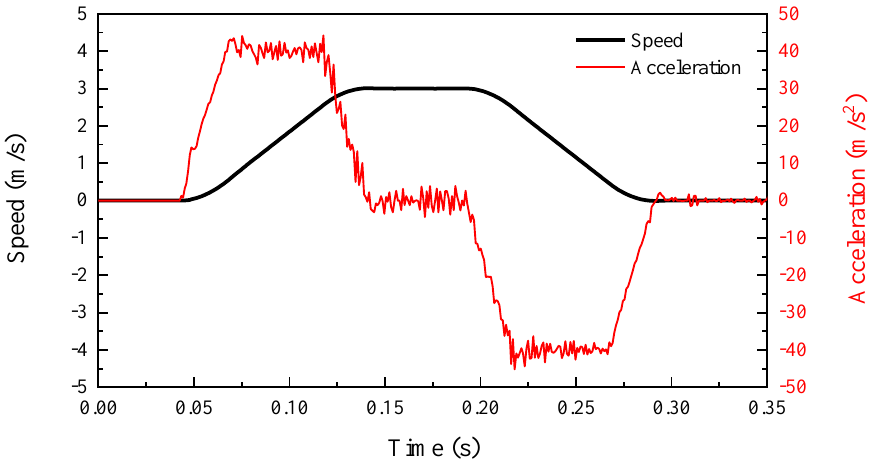
Figure 17. Measured temperature distribution under DC current loading of 2A between phases U and V.